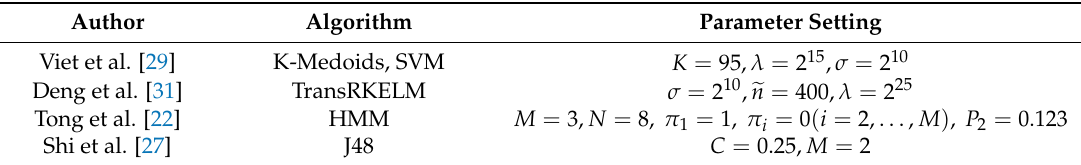
Table 5. Details of two models proposed in literature.